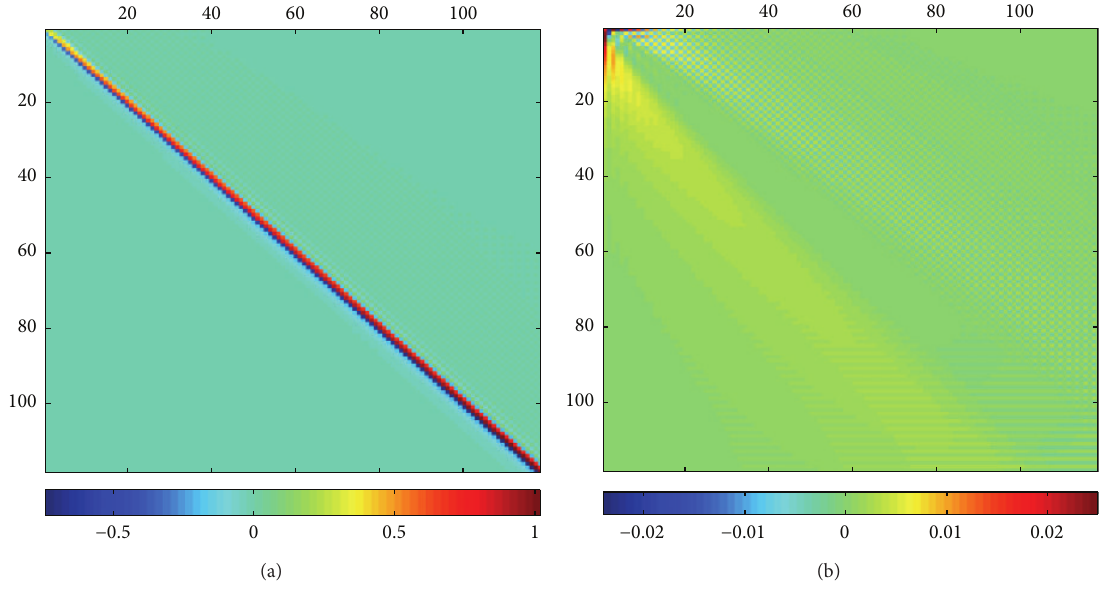
Figure 4: The absolute value of the transformation matrix for (a) 𝑇 𝑧𝑙 and (b) 𝑇 𝑧𝑡 .